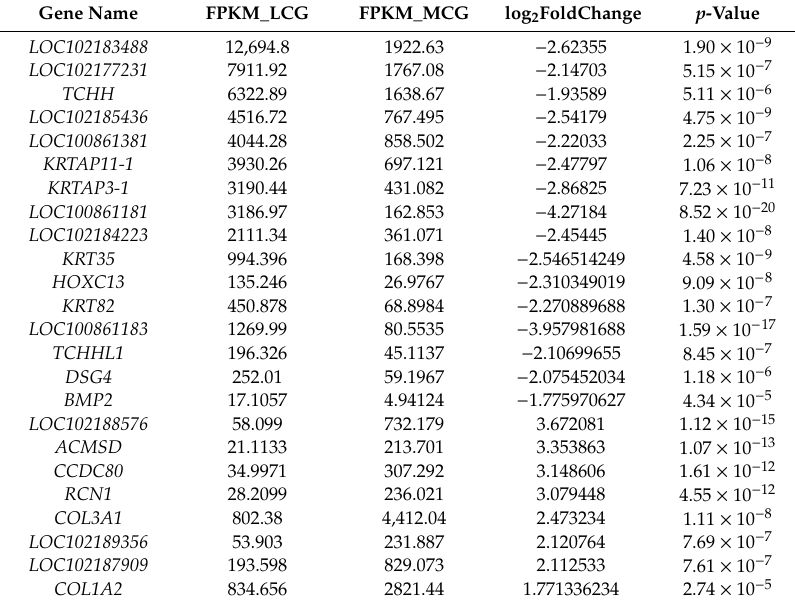
Table 3. Di ff erentially expressed genes in LCG and MCG.